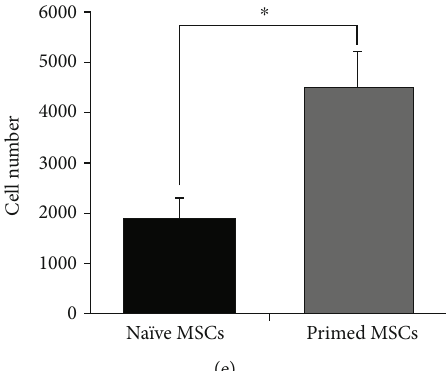
Figure 4: The therapeutic e ffi cacy of primed MSCs in vivo. (a) The level of apoptosis was measured after the injection of naïve and primed MSCs into the lateral ventricle of mouse brains and expressed as a percentage of the WT controls. (b) Secreted amyloid-beta levels were measured by Western blots and expressed as a percentage of the WT controls. (c) The deposition of amyloid-beta in the cortex and hippocampus was visualized by thio fl avin-S staining, and the intensity was measured and plotted as a histogram. Scale bar: 100 μ m. (d) The standard curve was fi tted to the linear regression for real-time quantitative PCR (qPCR) analysis. (e) The absolute number of cells in the brains of mice in the naïve MSC and primed MSC groups was calculated. The data are presented as the mean ± S : E : M . N = 3 per group. ∗ p < 0 : 05 .